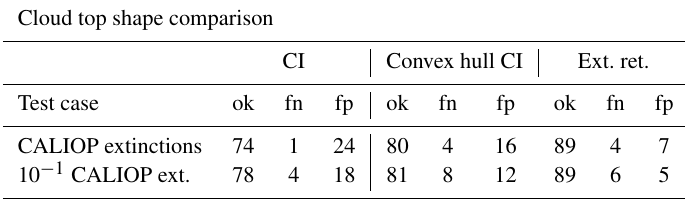
Figure 6. Comparison of cloud top detection capability for the various discussed methods and the IRLS instrument. Panel (a) shows the cloud extent contained in the CALIOP data. Panel (b) shows the cloud extent according to the CI. Panel (c) shows the cloud extent according to the convex hull CI algorithm. Panel (d) shows the cloud extent according to the tomographic extinction retrieval. In all panels, the orange line shows the true cloud top altitude, where clouds are present above 7km with a lower limit of 7km. The red line shows the cloud top altitude according to the depicted algorithm. The satellite looks northwards in these simulations. Table 2. This table aggregates the difference between the true cloud top shape and determined cloud top shape for 440 CALIOP orbits acquired in December 2012 for simulated IRLS measurements. All values are in